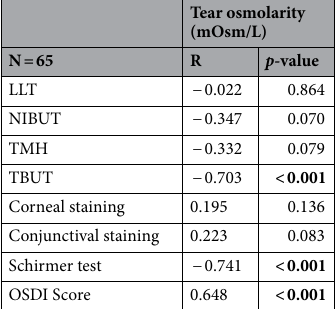
Table 2. Relationship between tear osmolarity and other dry eye parameters. Bold values indicate statistical significance ( p < 0.05).